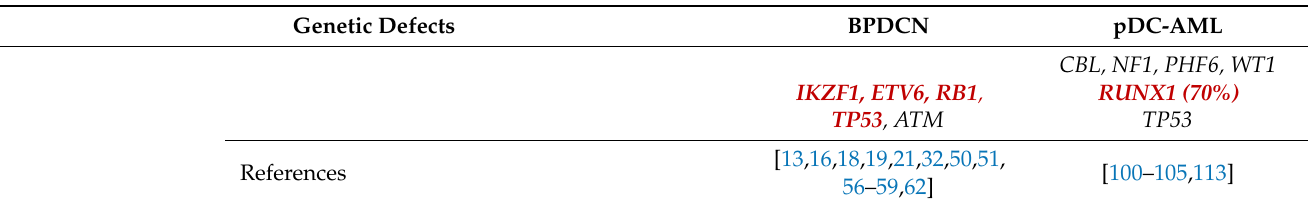
Table 1. Cont . Genetic